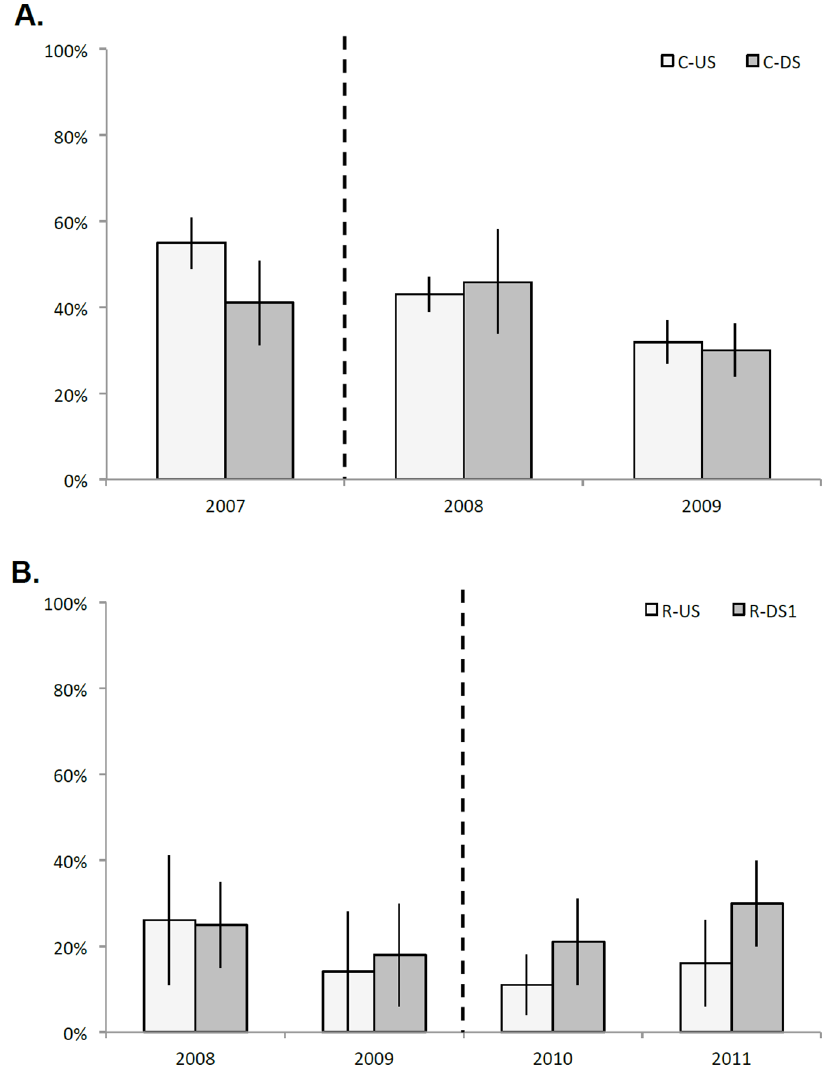
Figure 7. Mean %clingers (expressed as relative abundance, + / 2 2 standard errors) per reach across A) riffle sample units on the Calapooia, and B) transects sampled on the Rogue. In both panels, year is on the x-axis, and lighter-colored bars represent the upstream reaches. Vertical dashed line shows timing of dam removal. Note that, in the interest of space, the second downstream reach is not plotted for the Rogue due to the lack of change over